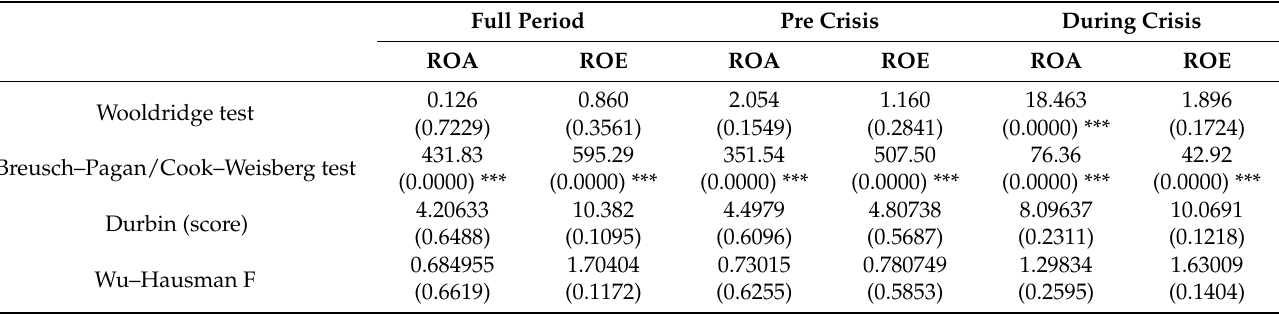
Table 4. Diagnostic